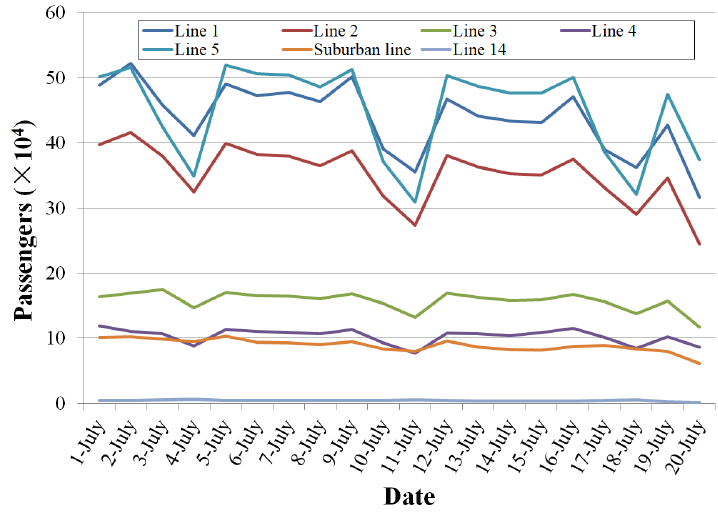
Figure 16. Daily passengers for seven Metro lines.